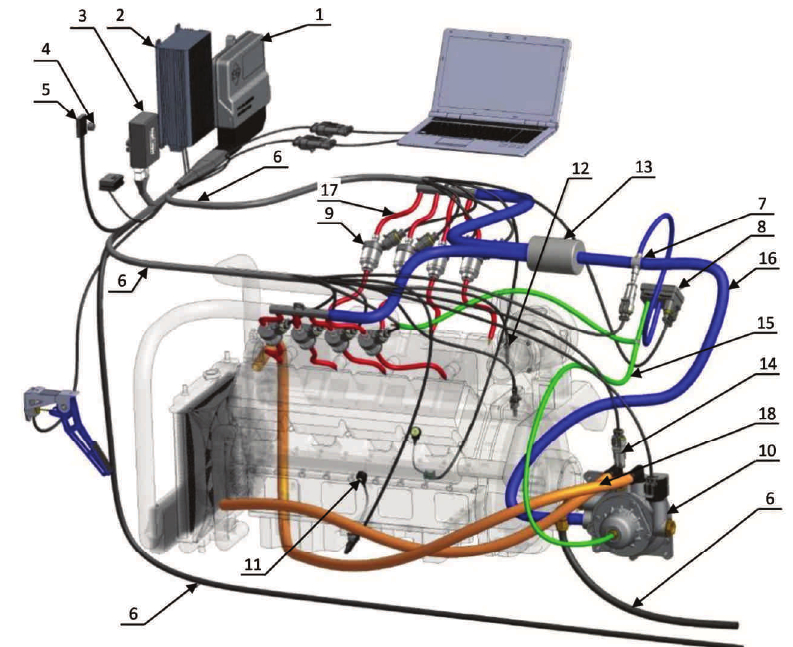
Fig. 2. Scheme of installation of CNG supply of OSCAR-N Diesel SAS type [20]: 1 – controller, 2 – power supply of the system- inverter 24V/12V – DC/DC, 3 – emulator TPS, 4 – buzzer, 5 – switch, 6 – wiring harness, 7 – measuring Tee, 8 – MAP sensor, 9 – injectors, 10 – reducer, 11 – knocking sensor, 12 – thermocouple, 13 – filter of violate phase, 14 – sensor of reducer’s temperature, 15 – pipe – pressure in the manifold, 16 – pipe – low pressure of gas, 17 – pipe – low pressure of gas, 18 – pipe – heating of reducer, 19 – high-pressure pipe – supply of gas from